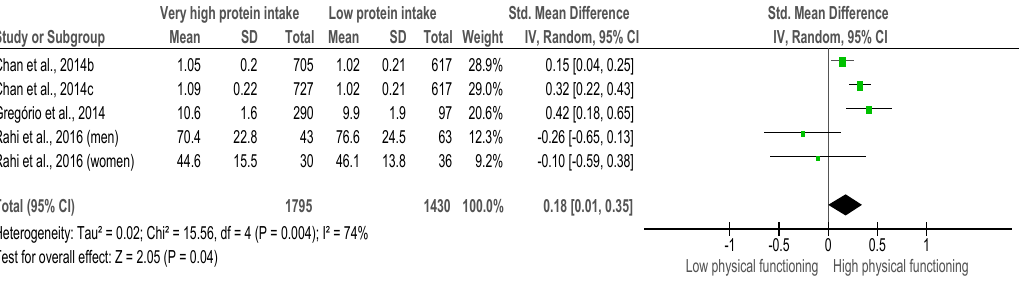
Figure 4. Mean difference in ( a ) Upper-limb muscle strength ; ( b ) Mobility ; and ( c ) Lower-limb muscle strength according to protein intake. Squares represent study-specific estimates; diamonds represent pooled estimates of random-effects meta-analyses.